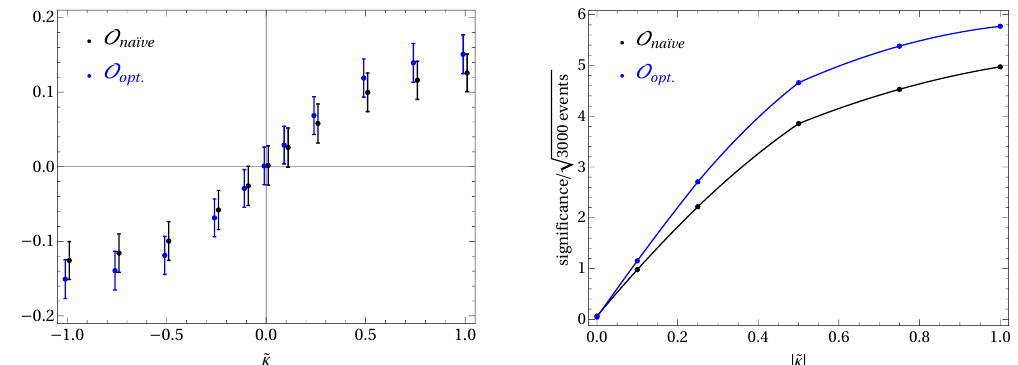
Figure 4 . Left: comparison of the optimized spin observable (blue dots) with the na(cid:127)(cid:16)ve observable (black dots) extracted from 3000 pp ! thj; t ! b‘(cid:23) MC events at each choice of ~ (cid:20) . Right: compar- ison of the signi(cid:12)cance (de(cid:12)ned as the mean value divided by the standard deviation) per the two observables, where N is the number of